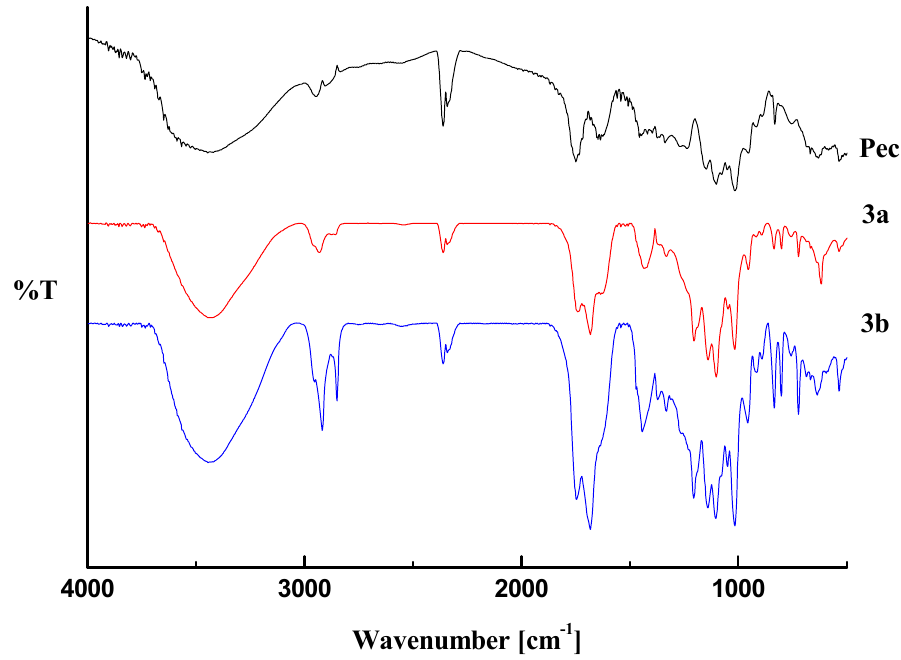
Figure 3. Transmittance FT-IR spectra pectin-palmitate ( 3 ) and